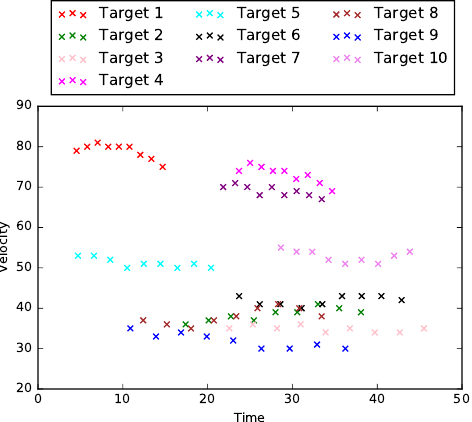
Figure 2. Example of X 1 for a single road